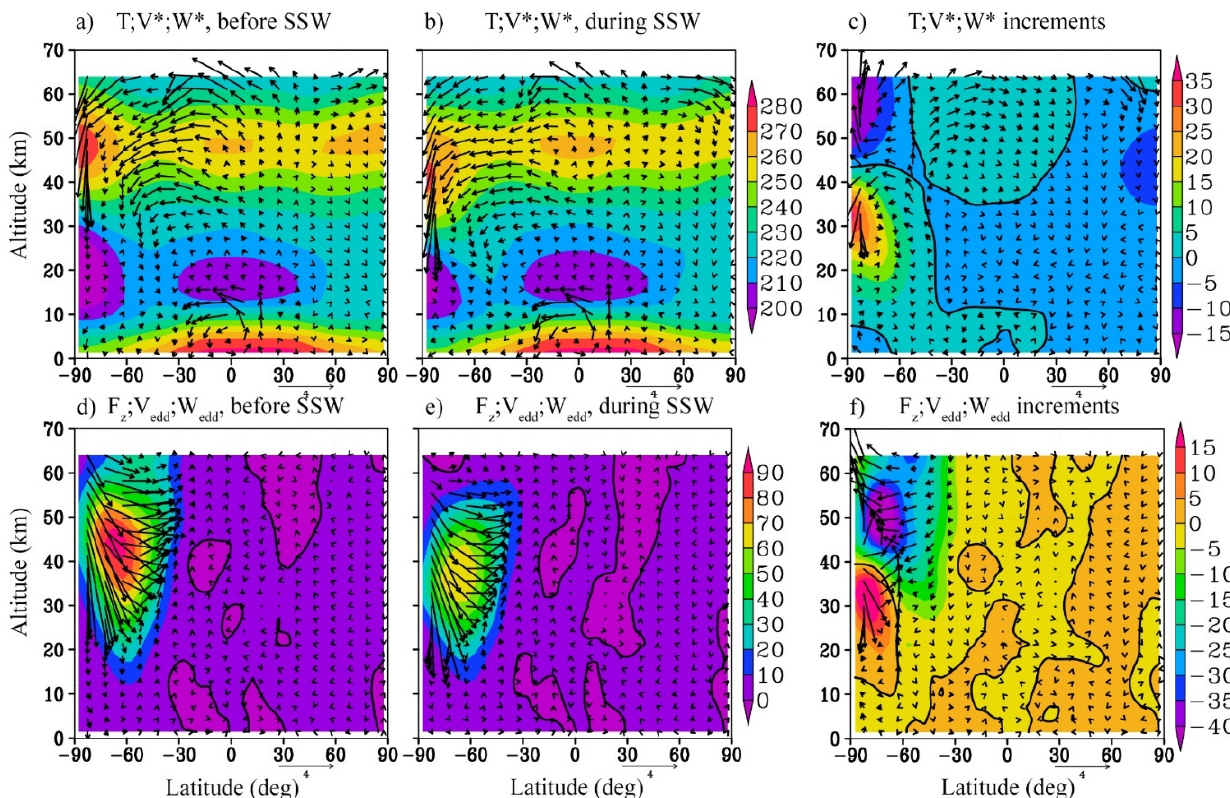
Figure 5. ( a ) Latitude-height distributions of temperature (shaded) and the residual mean circulation (RMC) components (m/s, arrows) before the peak SSW ( a ): ten-day average from 26 August–5 September 2019). ( b ) Same as ( a ) but during the SSW peak (6–19 September 2019). ( c ) changes between the specified parameters ( a , b ). ( d , e ) show Fz (10 4 m 3 /s 2 , shaded) and wave-induced eddy meridional circulation (m/s, arrows) during the same time intervals as ( a , b ). ( f ) changes between the specified parameters ( d , e ). Where V*, W* are residual meridional and vertical velocity components. The vertical component of the circulation is multiplied by 200.